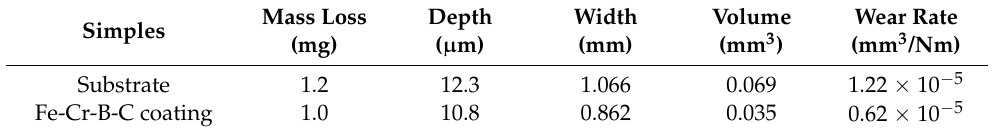
Table 2. Result of friction and wear test of the Fe-Cr-B-C coating and substrate. Simples